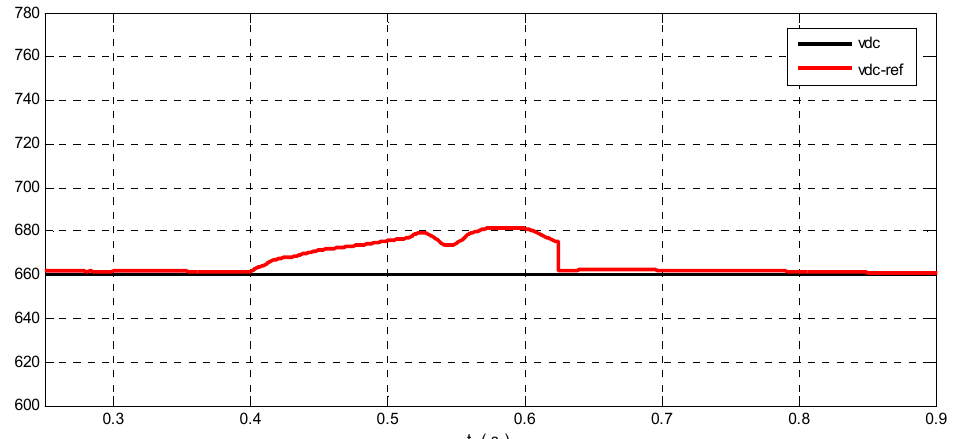
Figure 23. The active and reactive power fed to the grid.